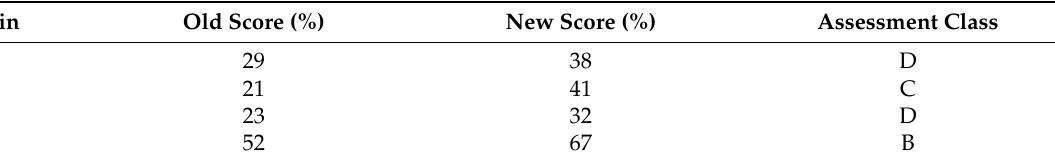
Table 1. The results of the different technical domains scores after implementing the modifications of the technical improvements package in Case